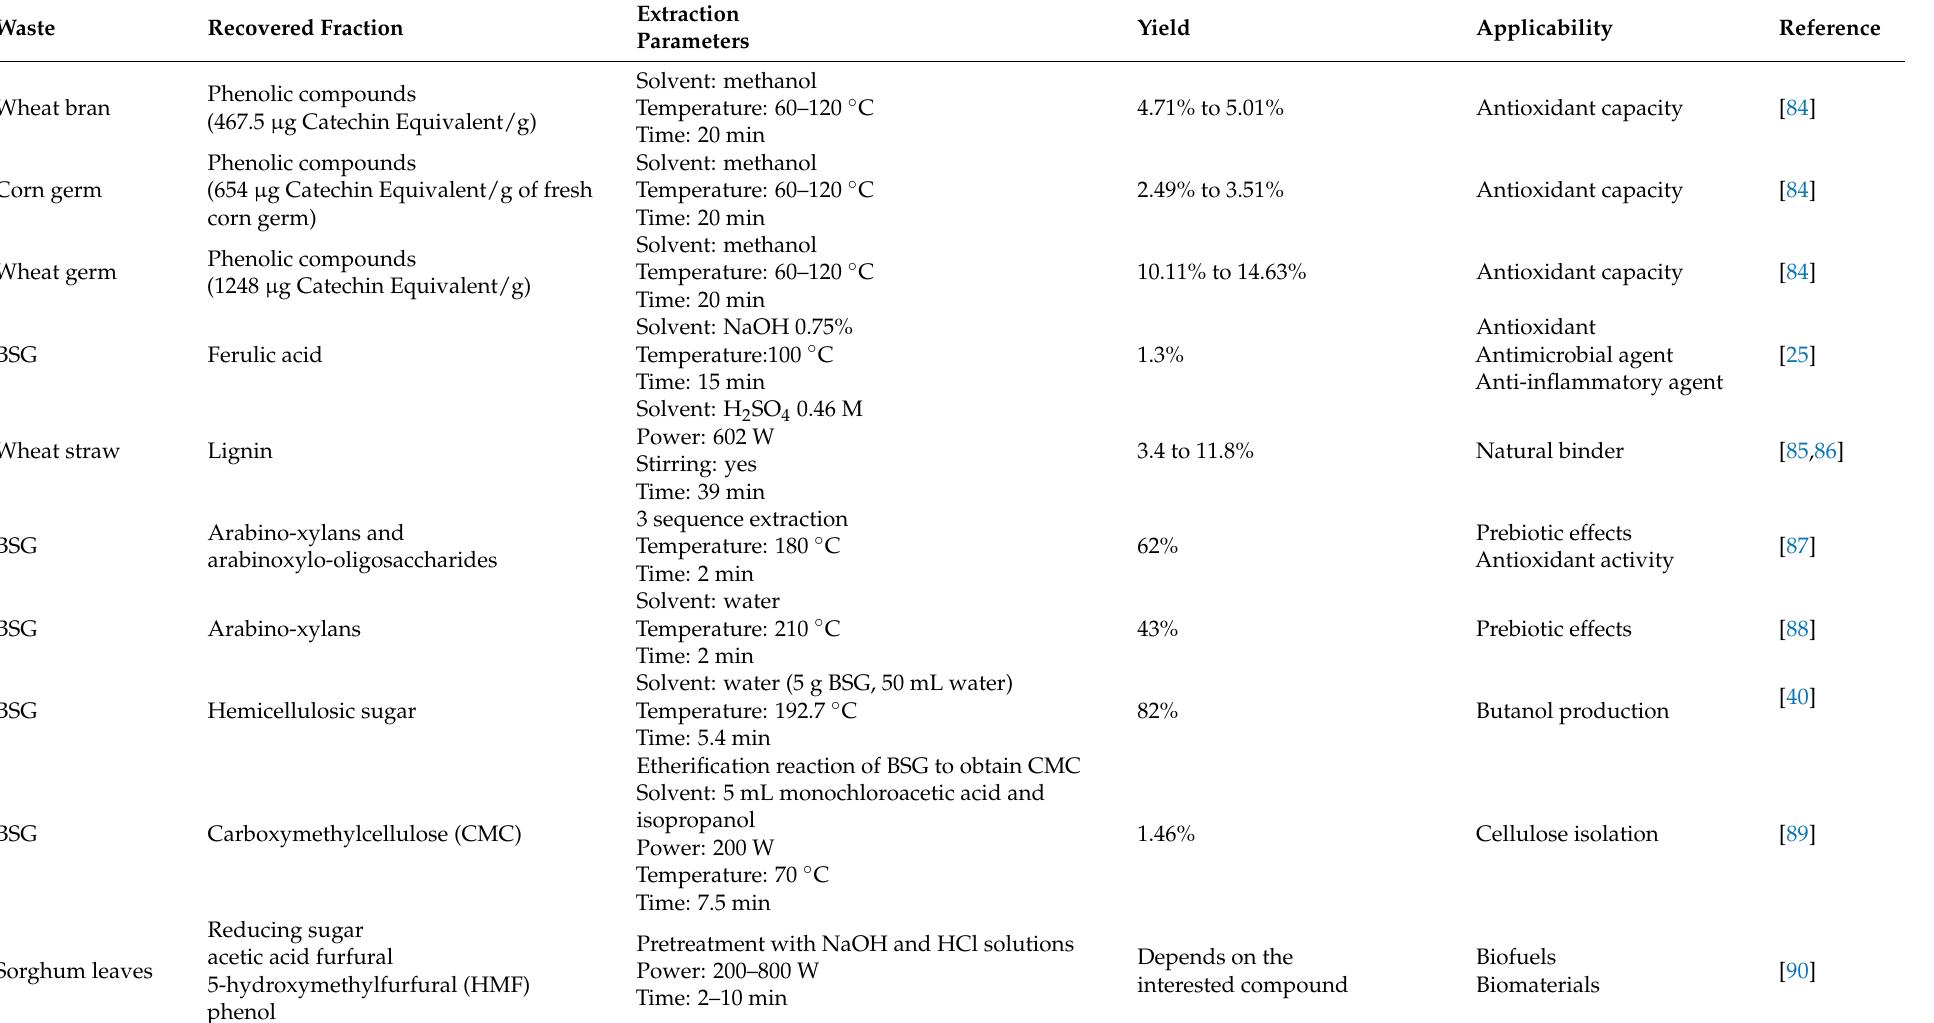
Table 4. The main valuable components from cereal waste recovered using